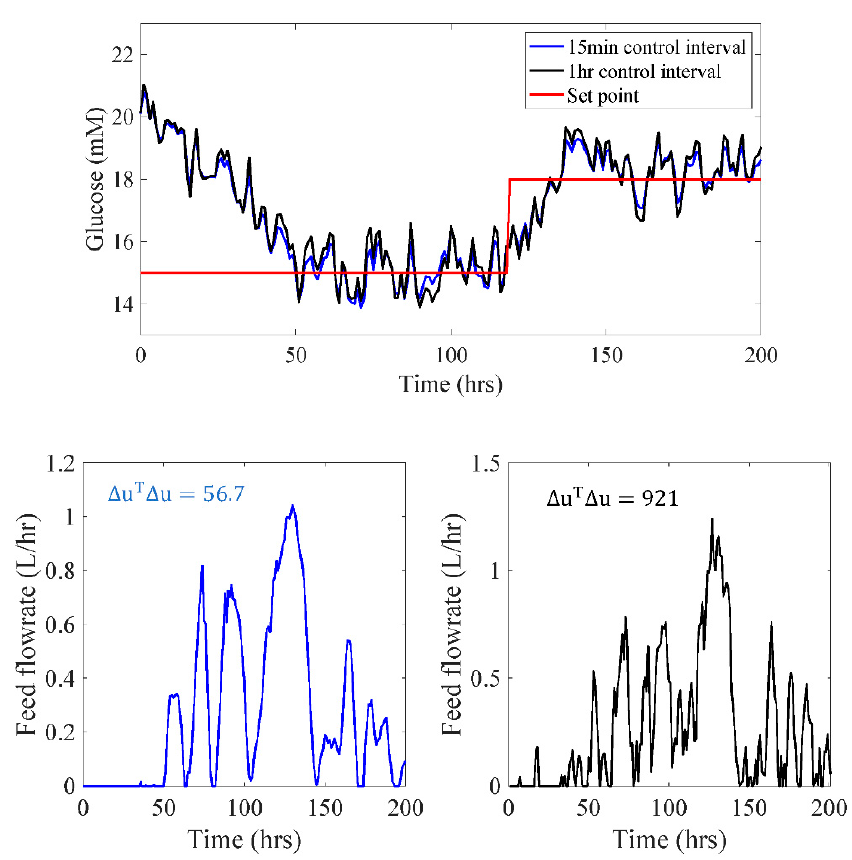
Figure 9. A comparison of the MPC performance for control intervals of 1 h and 15 min.